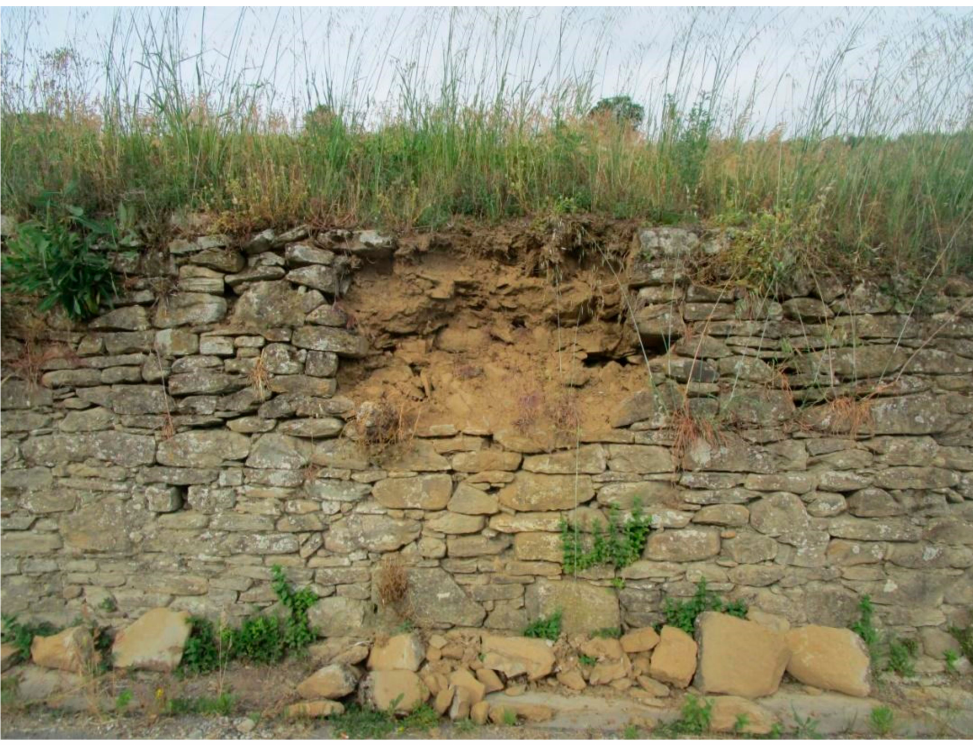
Figure A5. Damage class 5—Failure.